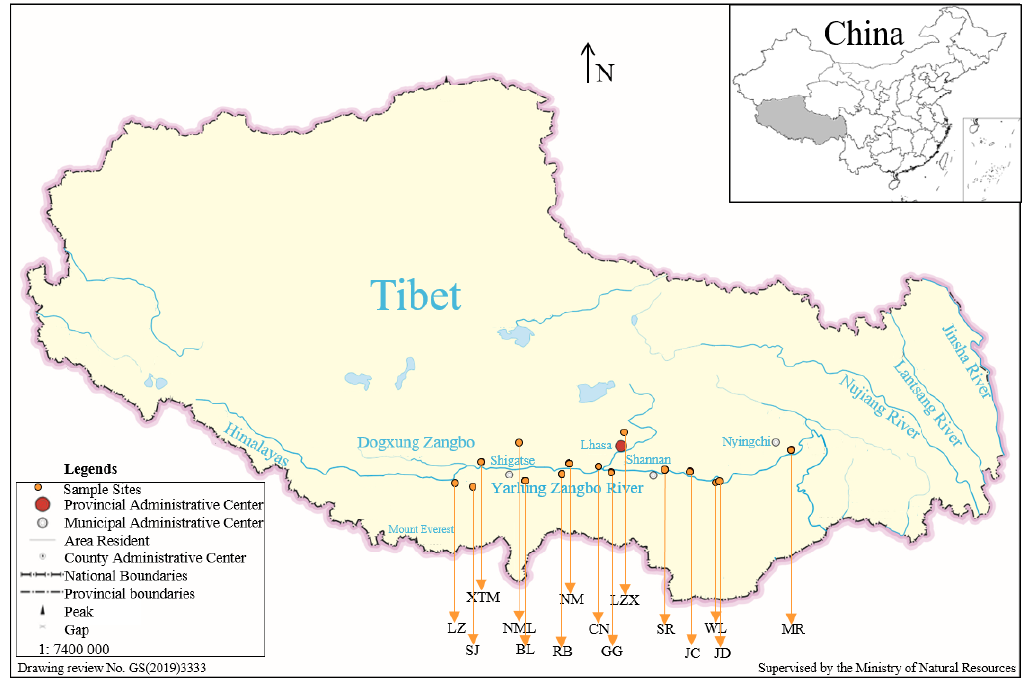
Figure 1. Fifteen sampling population sites of S. moorcroftiana in Qinghai – Tibet Plateau for genetic diversity analysis. All abbreviations in Figure 1 are defined as follows: Sajia County (SJ), Linzhou County (LZ), Xietongmeng County (XTM), Nanmulin County (NML), Bailang County (BL), Renbu County (RB), Nimu County (NM), Caina County (CN), Gongga County (GG), Lazi County (LZX), Sangri County (SR), Jiacha County (JC), Wolong County (WL), Jindong County (JD), and Mirui County (MR).